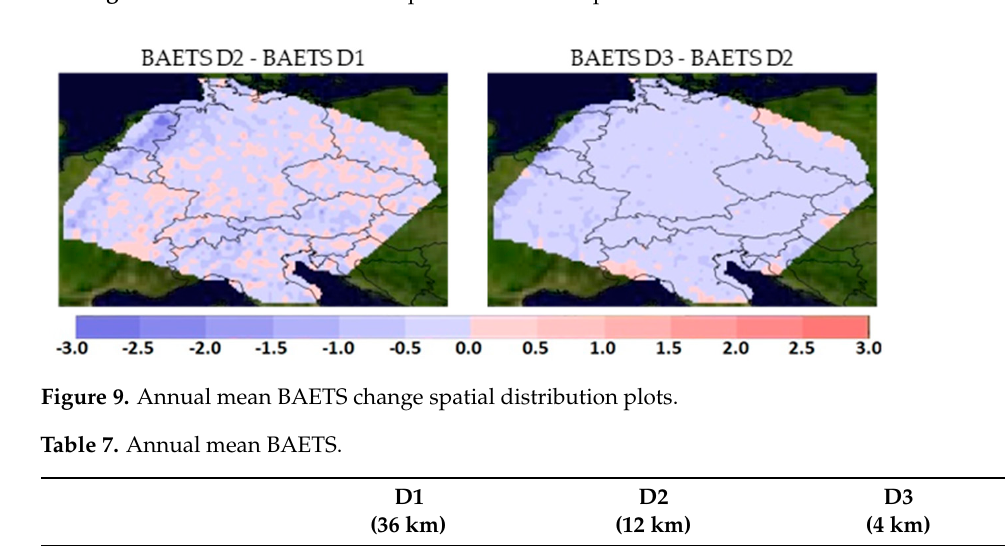
Figure 8. Annual mean BAETS spatial distribution plots.